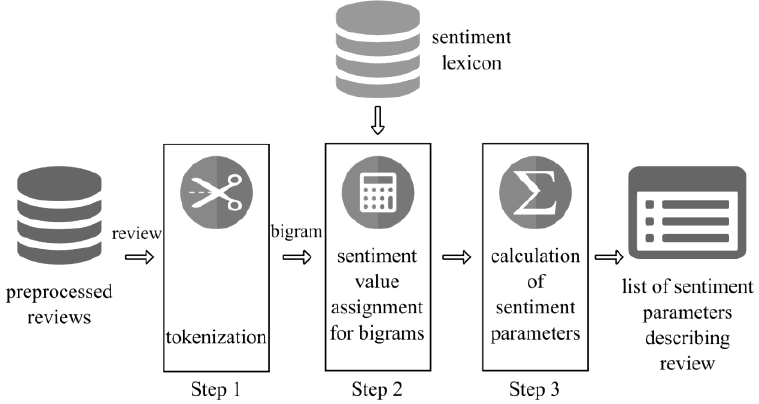
Fig. 5. The main steps of sentiment